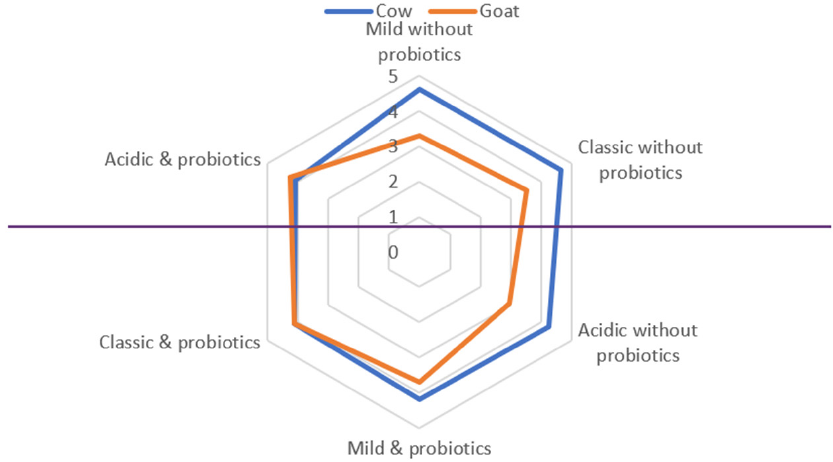
Figure 1. Spider graph of the yogurt dessert flavor.